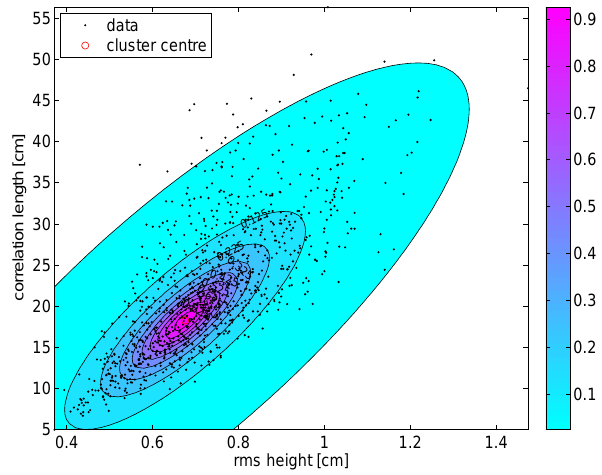
Fig. 2. Contours of the joint possibility distribution for rms height and correlation length for the rotary tilled roughness class (Vernieuwe et al. (2011)).